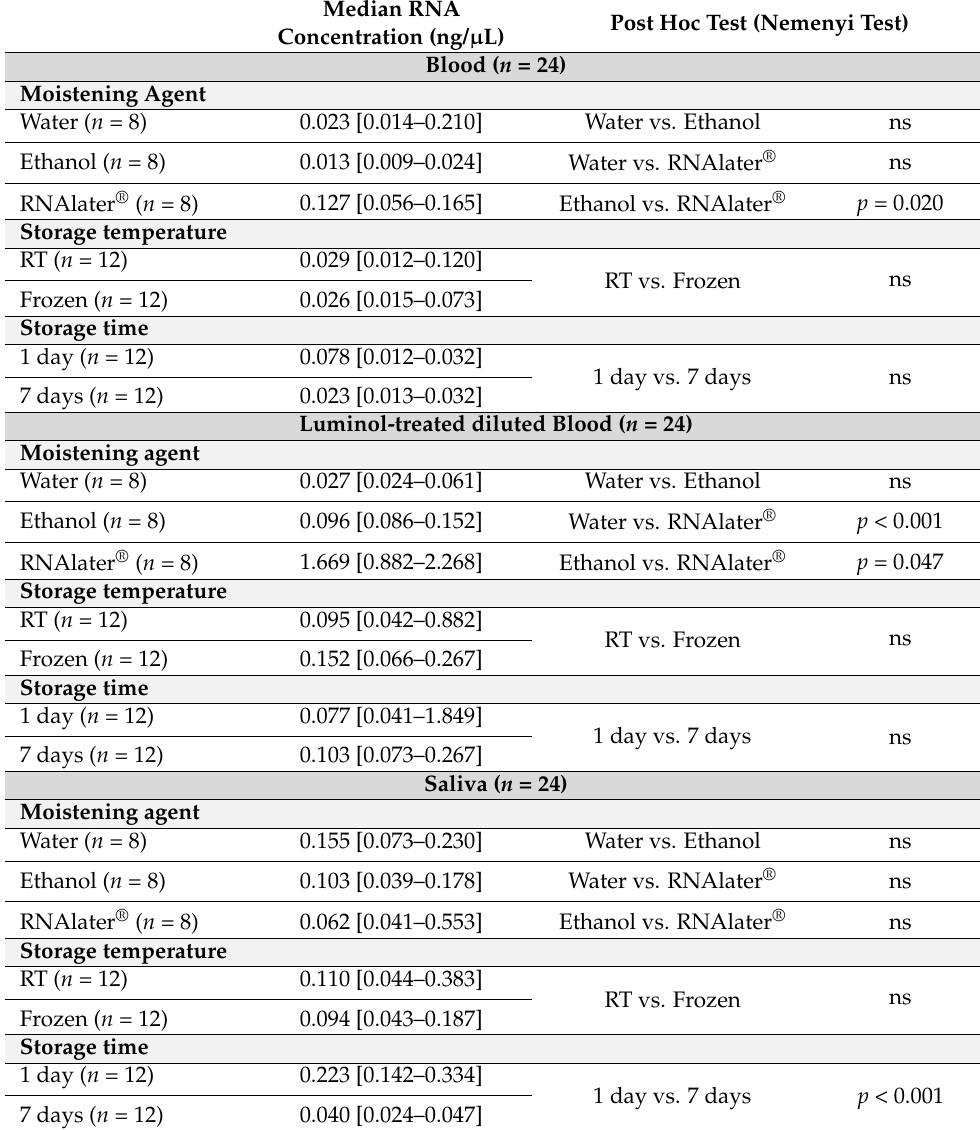
The median concentrations of the total RNA isolated from the stains are shown in Table 2. The maximization of RNA retrieval following the use of RNAlater ® was observed in all tissues (the only exception being saliva), with differences reaching statistical significance in: whole blood, compared to ethanol; luminol-treated diluted blood and skin, compared to water and ethanol; semen, compared to water. As for the storage conditions, the only statistically significant differences in pairwise comparison resulted from swab storage time before extraction. Indeed, 1-day storage gave better results than 7-day storage in saliva; conversely, an increase in RNA yield was observed in semen stains between 1 and 7 days of storage. Table 2. Median concentrations of total RNA in experimental samples subdivided by stain type, moistening agent, storage temperature (RT: room temperature), and storage time before processing. The IQR is given between brackets. p -values of the Nemenyi test are shown in the column to the right (ns denotes